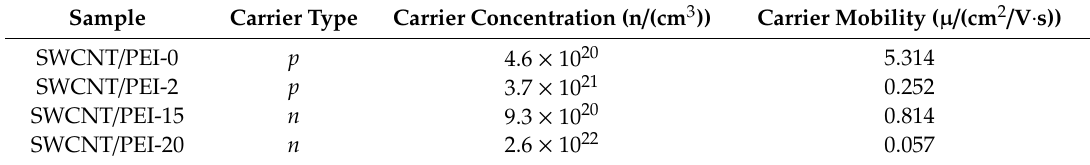
Table 1. Results of Hall effect test of SWCNT/PEI films at room temperature.